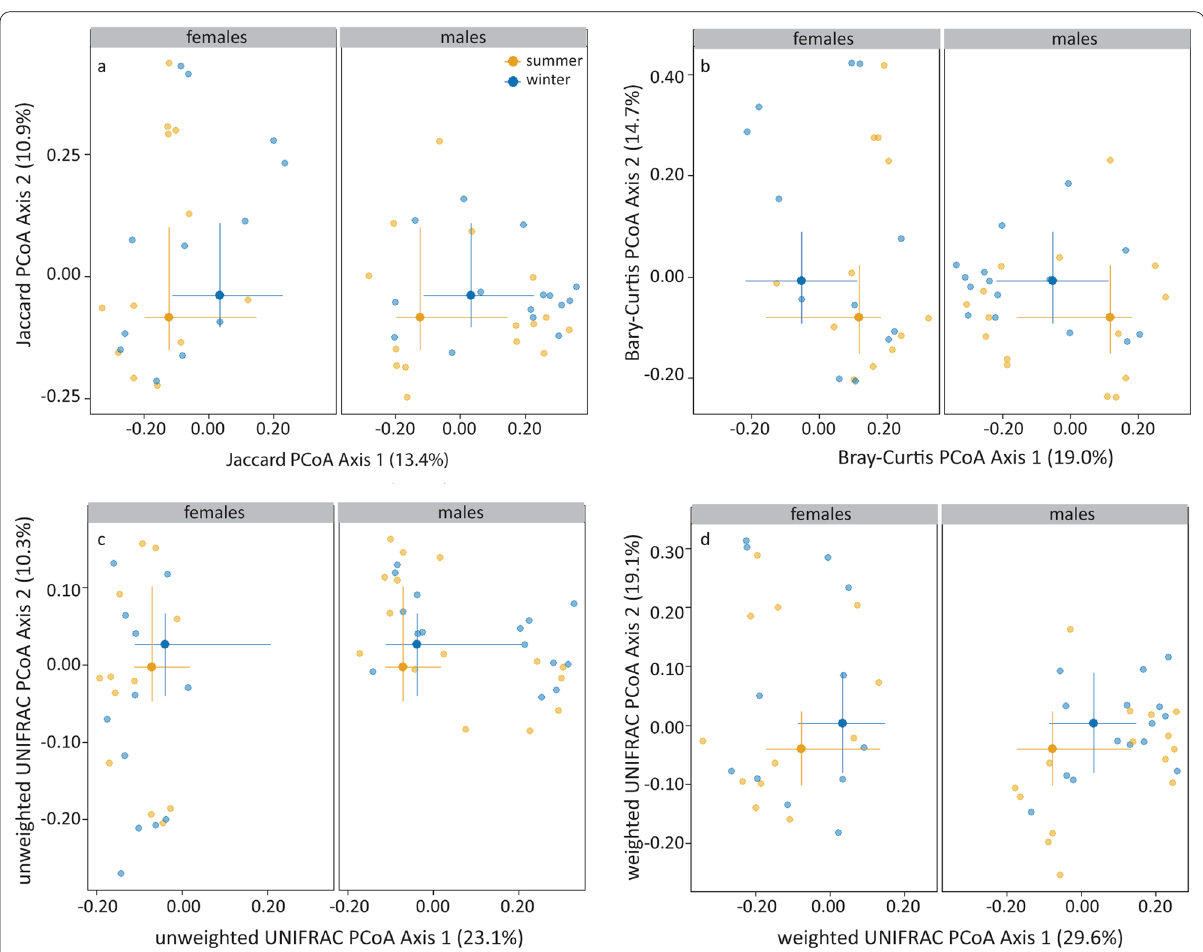
Fig. 4 Seasonal and sexual variation in Jaccard ( a ) and Bray–Curtis (dis)similarities ( b ), and unweighted ( c ) and weighted UniFrac distances ( d ) depicted in PCoA plots. Statistics are presented in the text. The large symbols represent the medians, the error bars the 25% and 75% quantiles. The transparent symbols present the underlying data